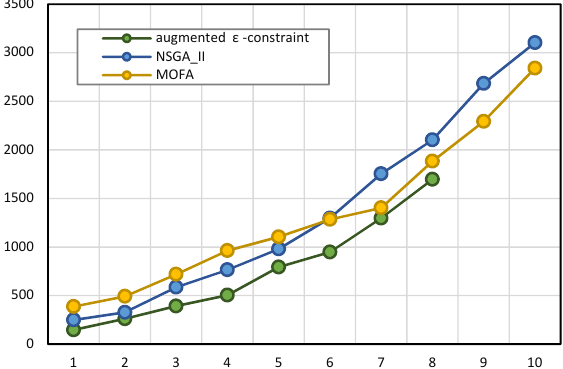
Figure 7. CPU time of the augmented ε -constraint method compared to the multi-objective firefly algorithm (MOFA).